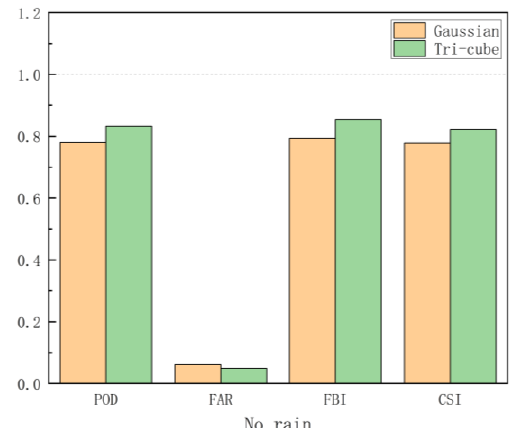
Figure 7. Cross-validation categorical statistics (POD, FAR, FBI, and CSI) for daily combined pre- cipitation data using two weighting functions (Gaussian and tri-cube) in the no-rain precipitation intensity class.